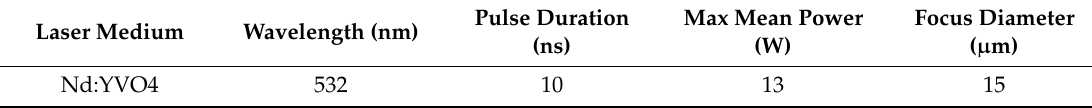
Table 5. Parameters used for the laser structuring process.